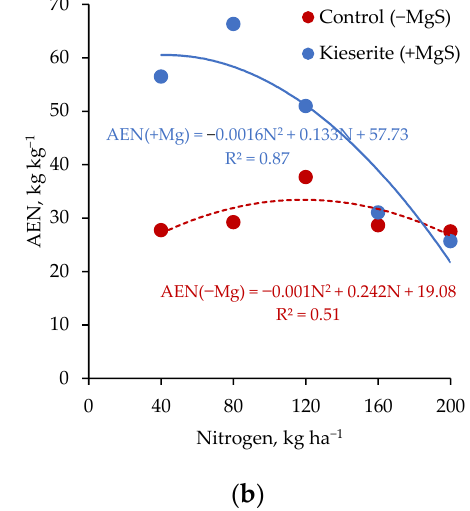
A E N ( − M g ) = − 0 . 089 N + 21 . 13 R ² = 0 . 7 7